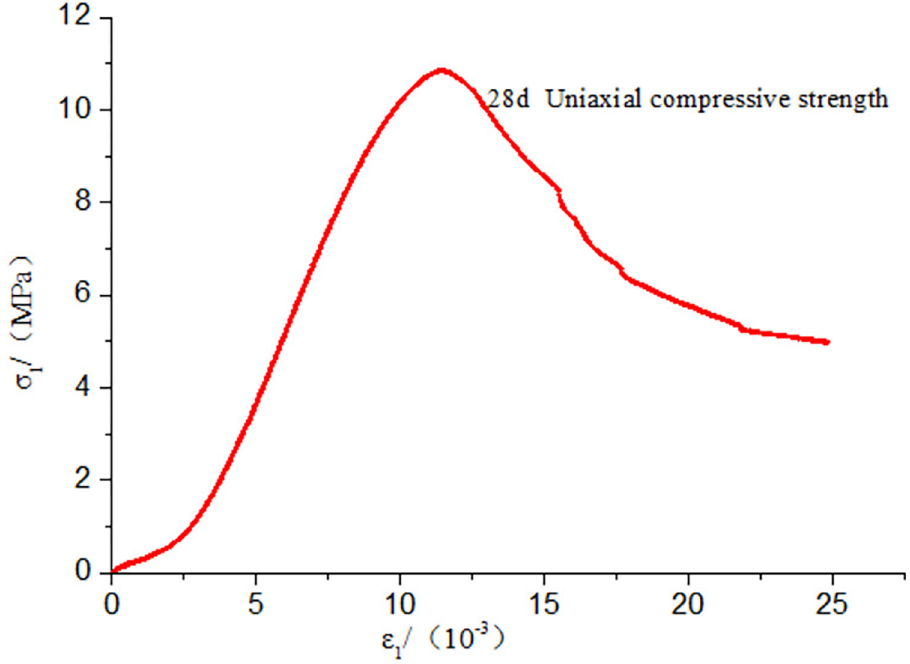
Fig 12. Uniaxial compressive stress-strain curve for the sealing